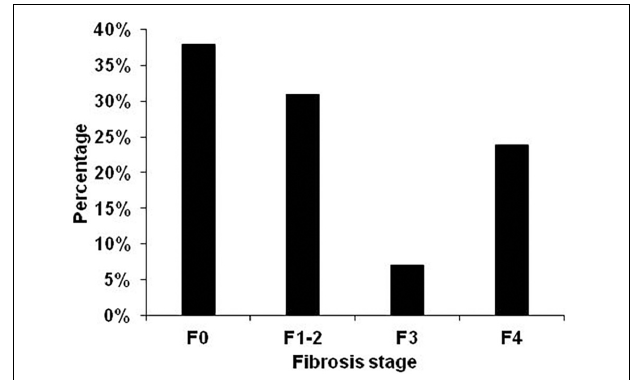
FIGURE 2 | Fibrosis distribution in all 114 patients. Fibrosis stage was non-invasively assessed by transient elastography using AST-adapted cutoff values for liver stiffness (Mueller et al.,